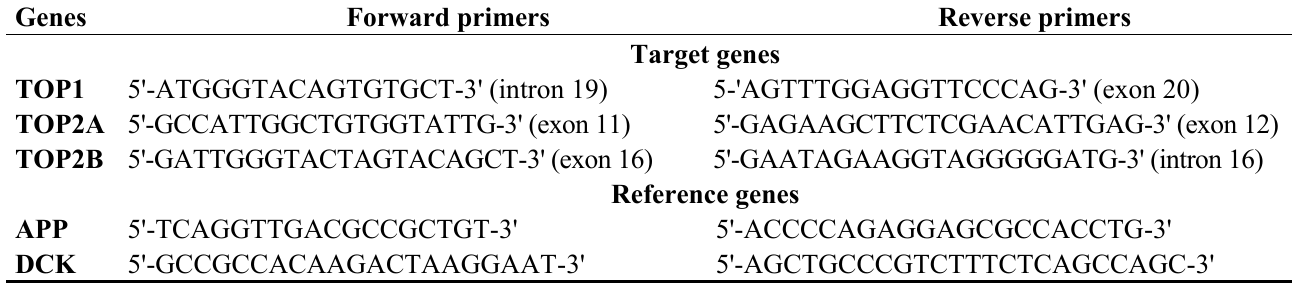
Table 5. Primers for the semi-quantitative PCR of TOP1 , TOP2A and TOP2B